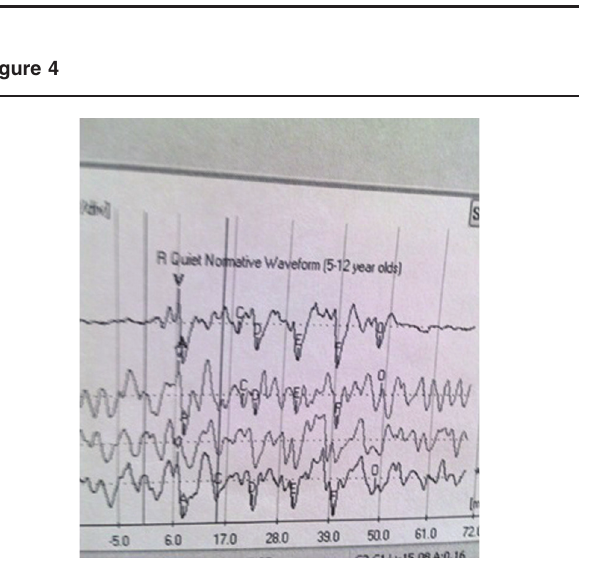
Speech-evoked auditory brainstem response in the left ear after 3 months of medical Treatment